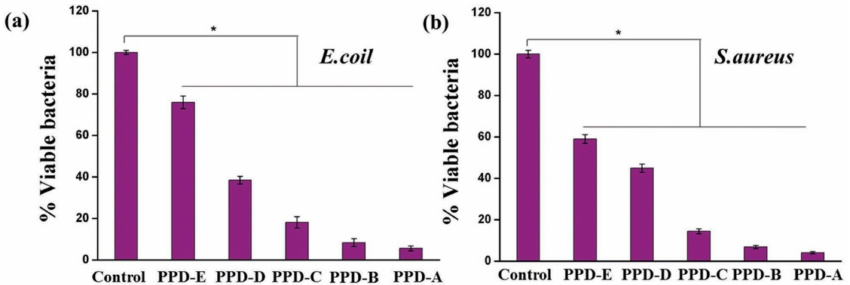
Figure 12. Antimicrobial properties of polyethylene glycol (PEG)-based hydrogels (PPD) hydrogels against various microbes. The bactericidal activity of PPD hydrogels with di ff erent DS of catechol (PPD-A: 2%, PPD-B: 5%, PPD-C: 8%, PPD-D: 18%, PPD-E: 25%) against ( a ) E. coli (Gram-negative) and ( b ) S. aureus (Gram-positive) ( n = 3, * p < 0.05). Reproduced with permission from Ref.